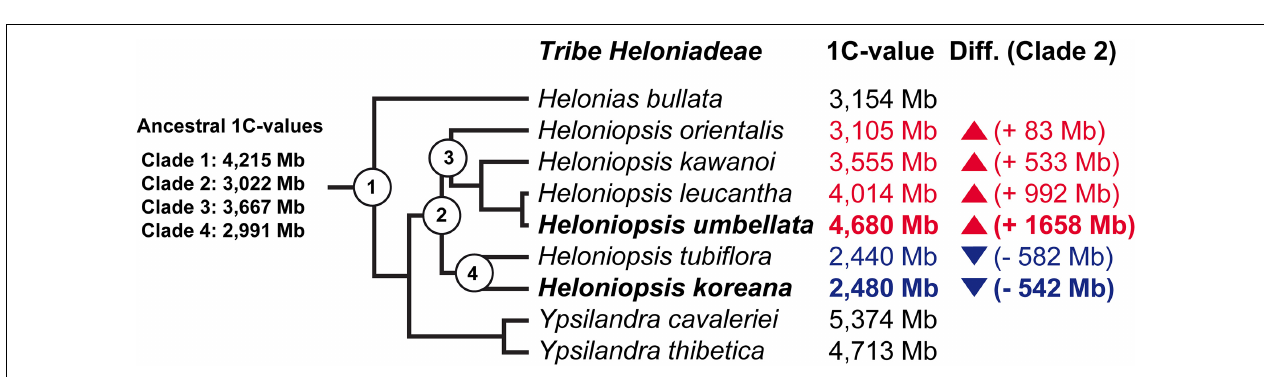
FIGURE 1 | Genomic composition of Heloniopsis koreana (2,480 Mb/1C) and H. umbellata (4,680 Mb/1C). Estimates of the genomic abundance (in Mb/1C) of different repeats are colored by repeat class. The size of the unclassified (pale purple) and low/single copy fraction (pink) of each genome is also shown.